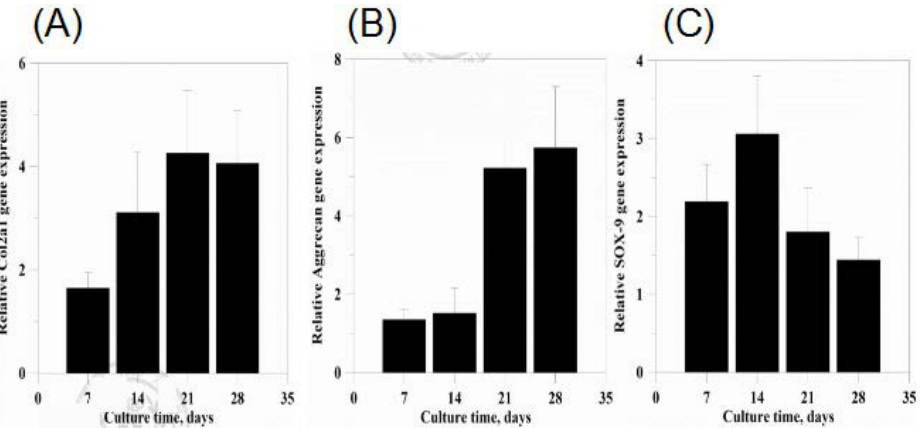
Figure 10. Chondrogenic differentiation of MSCs in aggregate culture following transduction. Relative expression of mRNA of ( A ) type II collagen; ( B ) aggrecan; and ( C ) Sox9 of MSCs cultured in vitro for up to 28 days. mRNA expression levels were normalized to the housekeeping gene GAPDH and control group.